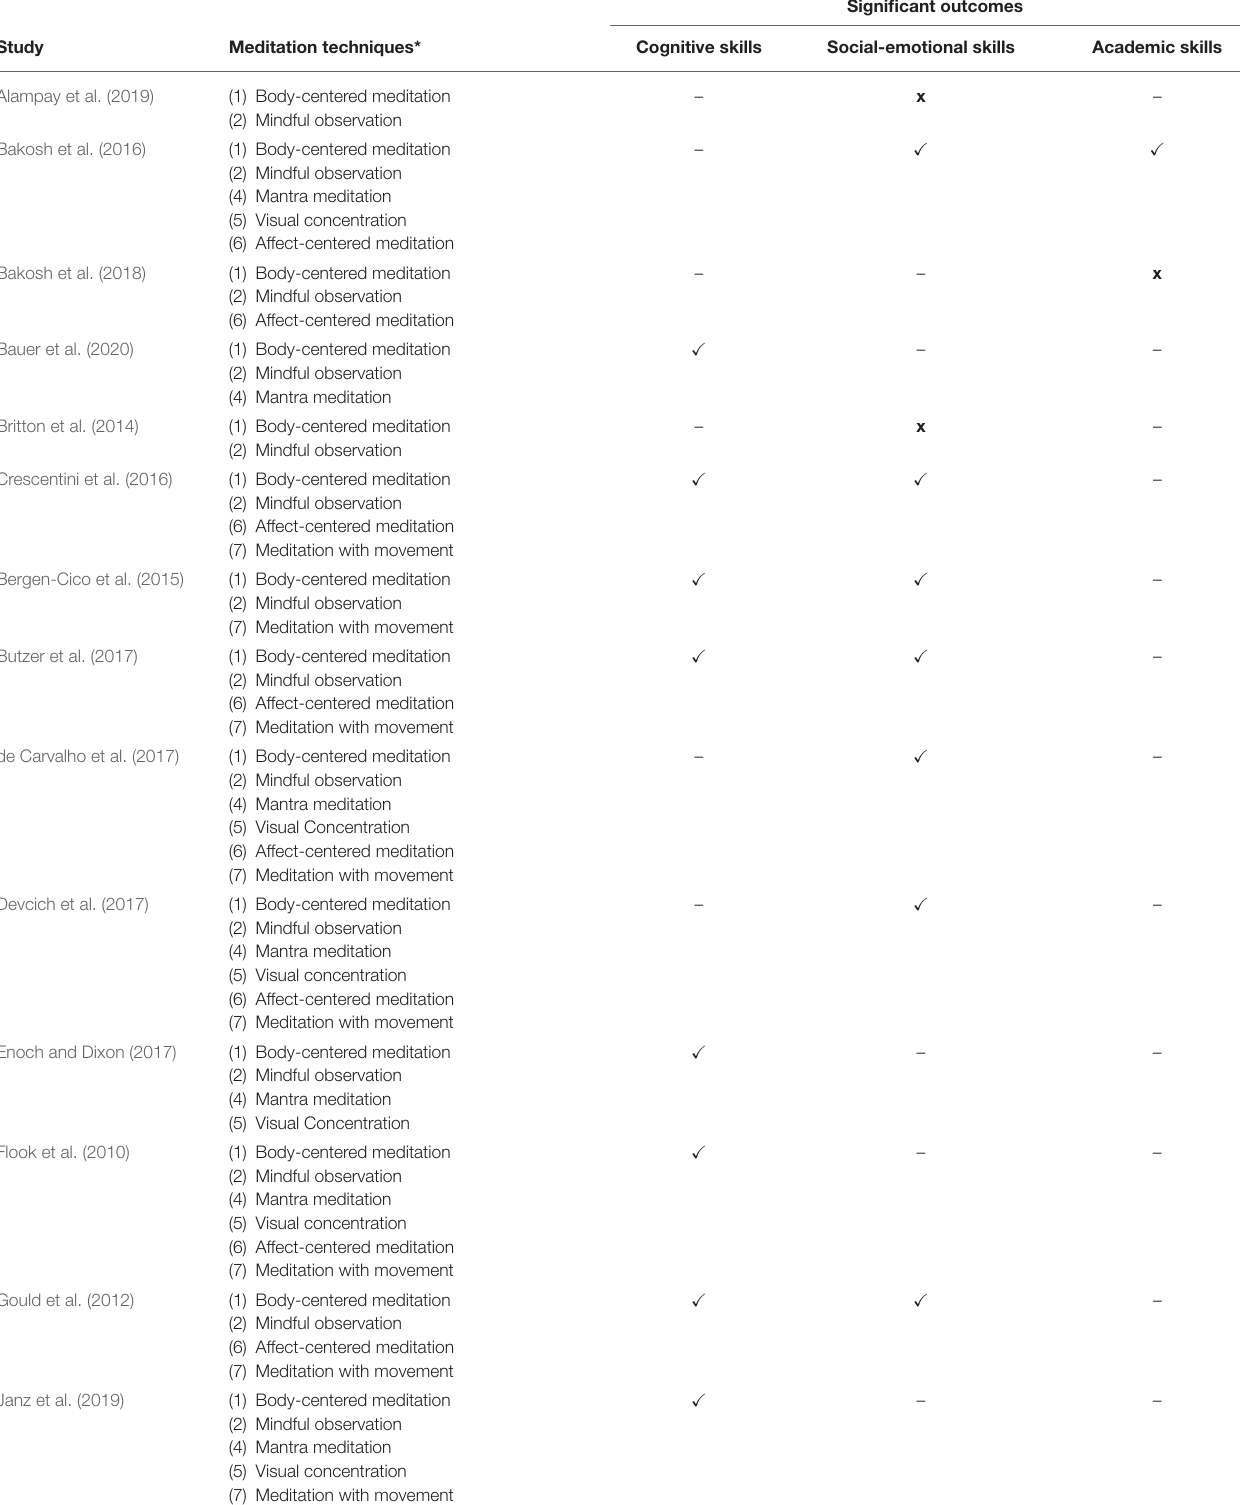
TABLE 4 | Mindfulness meditation techniques and significant cognitive, social-emotional, and academic outcomes of the included